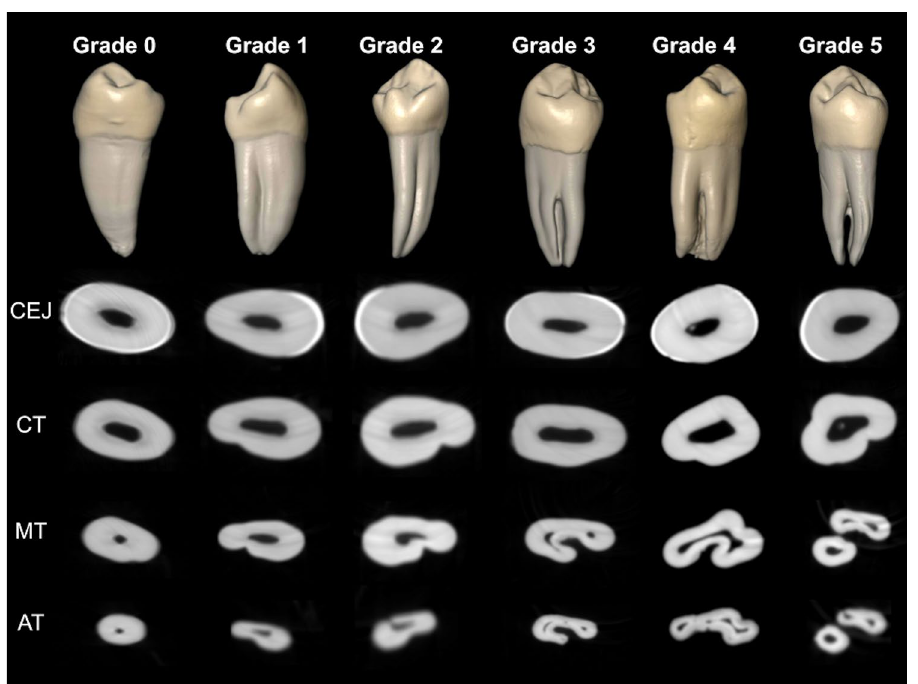
Figure 3. Micro-CT images showing the radicular grooves classified according to ASUDAS scoring. AT apical third; CEJ cementoenamel junction; CT cervical third; MT middle third (Images obtained using the CTAn v.1.12 software,